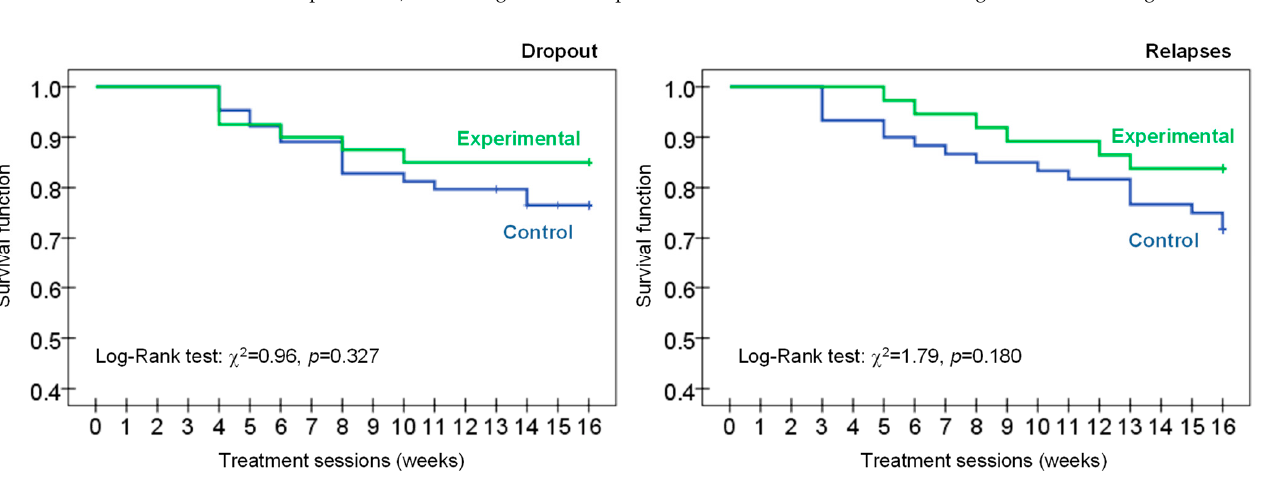
Figure 3. Survival analysis for the rate of dropout and relapses (Kaplan-Meier function) (total sample, n = 104).